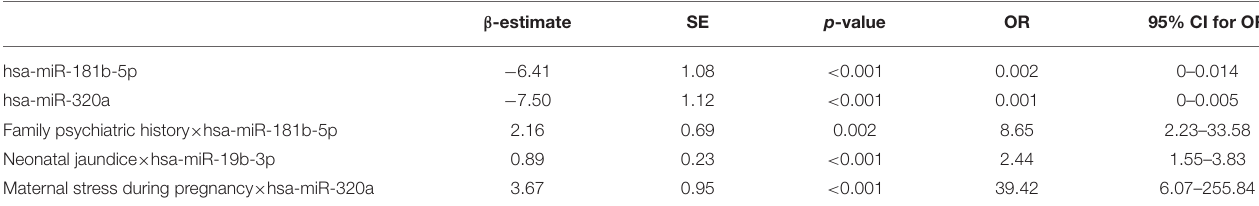
TABLE 2 | Logistic regression analysis for environment risks and miRNAs interaction effects. β -estimate SE p